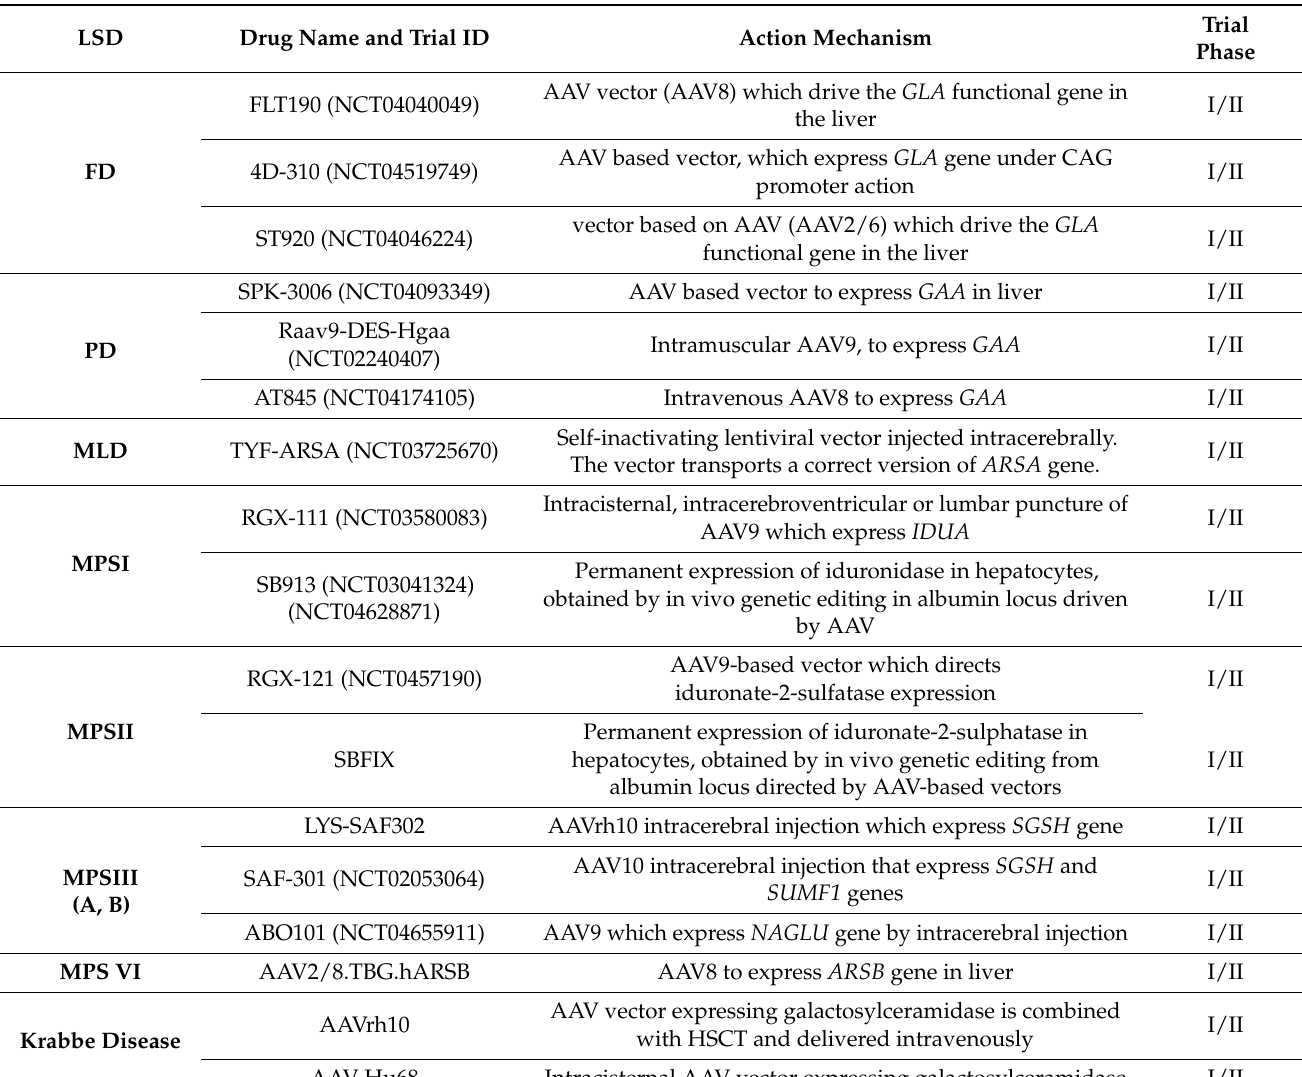
Table 3. In vivo gene therapy vectors under development for the treatment of